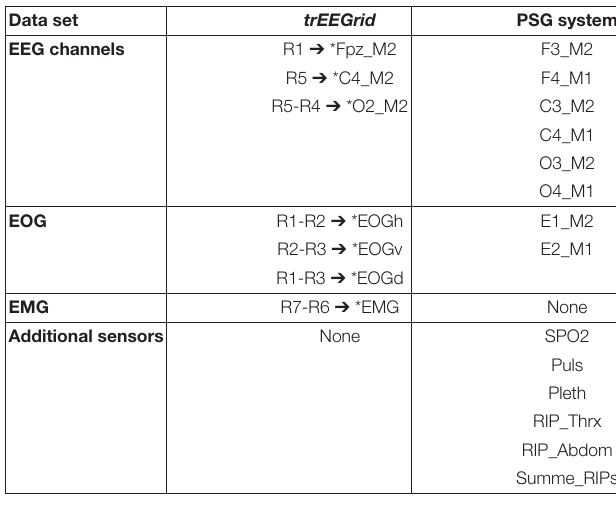
TABLE 1 | Channel configuration of the trEEGrid and PSG system data